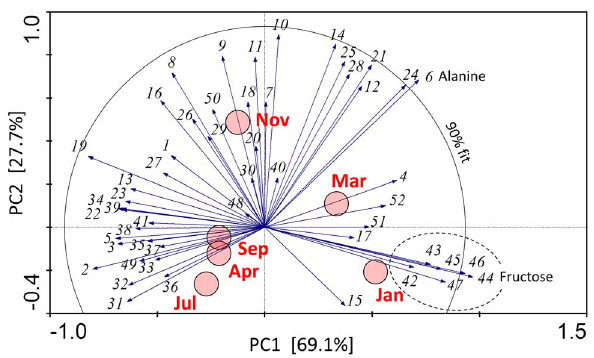
Figure 6. Hemolymph metabolom. Principal component analysis showing the association between sampling date (red circles) and the concentration of 52 different metabolites (eigenvectors) in the hemolymph of field-sampled caterpillars of Cydia pomonella during 2010/2011. The numbers coding for metabolites are decoded in Dataset S1. The eigenvectors of alanine (6), fructose (44), and mannitol (46) extend beyond the circle delimiting 90% fit of the model. The metabolites (42–47) most characteristic for winter (January) sample are enclosed by a dashed line ellipse.